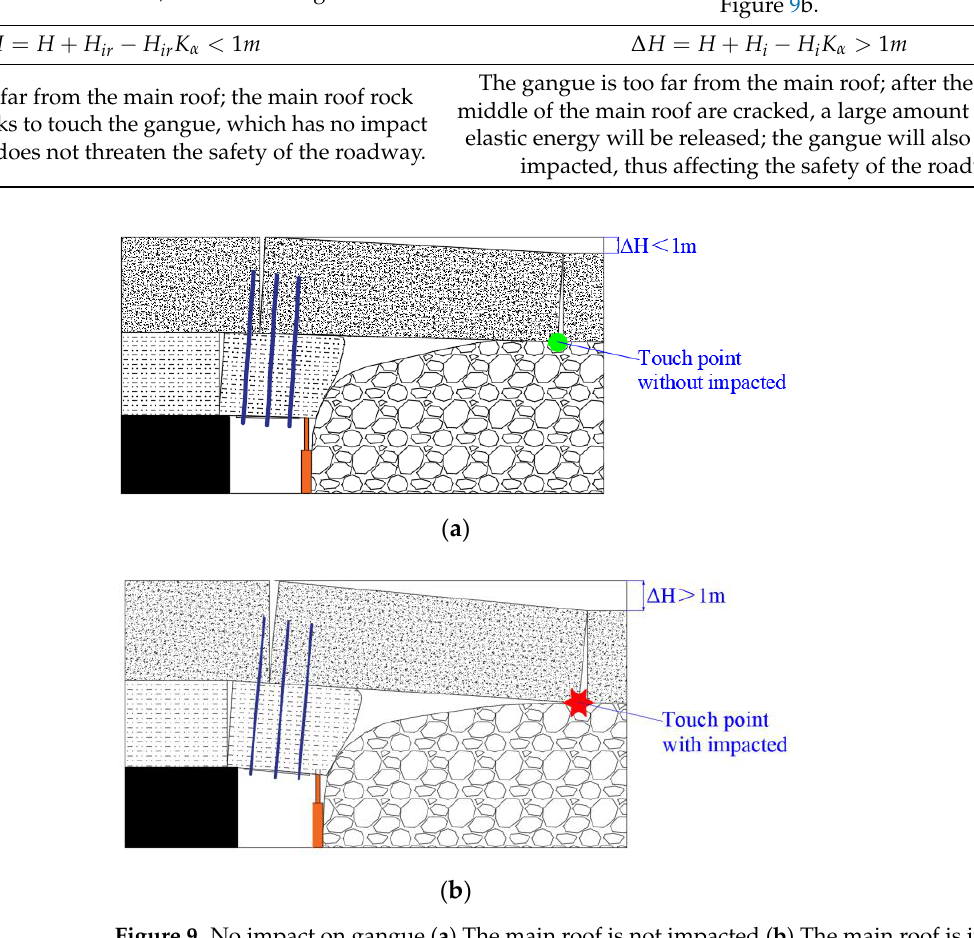
Figure 9. No impact on gangue ( a ) The main roof is not impacted ( b ) The main roof is impacted.